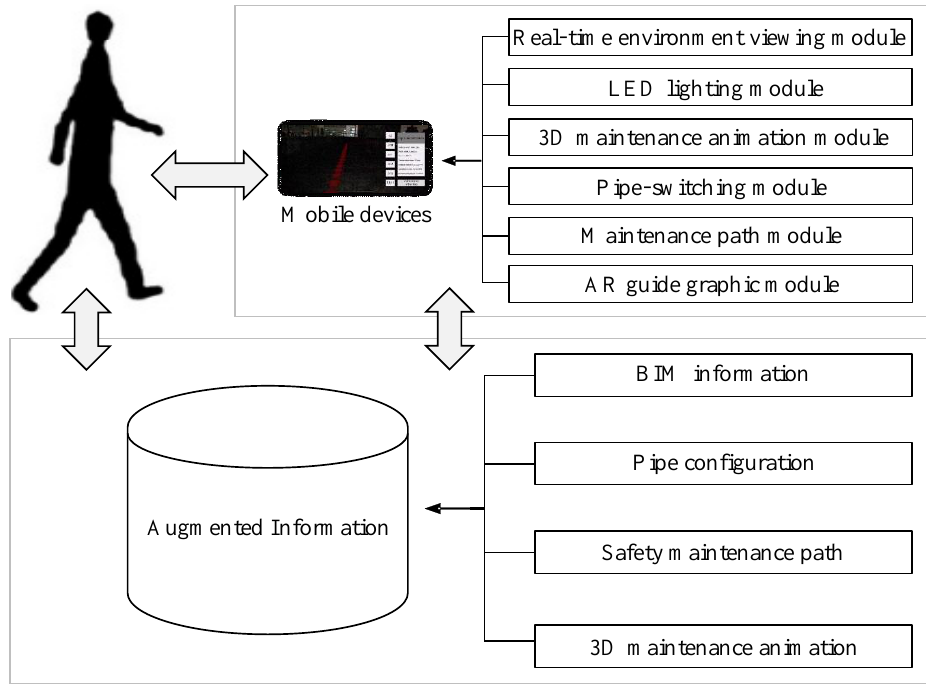
Figure 1. System structure and modules of BARMS.